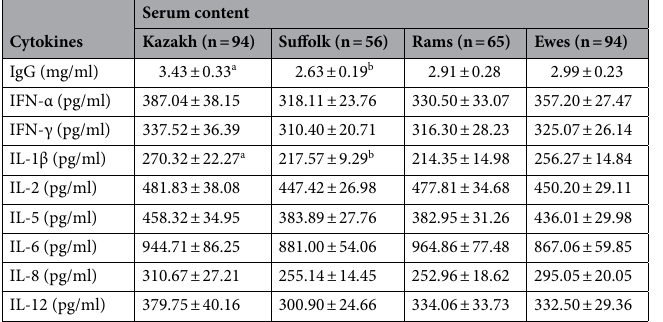
Table 1. Contents of IgG and 8 Cytokines in serum of Suffolk and Kazakh sheep*. *Means ± SEM marked with different lower-case letter either a or b in the same line were significant at P < 0.05.